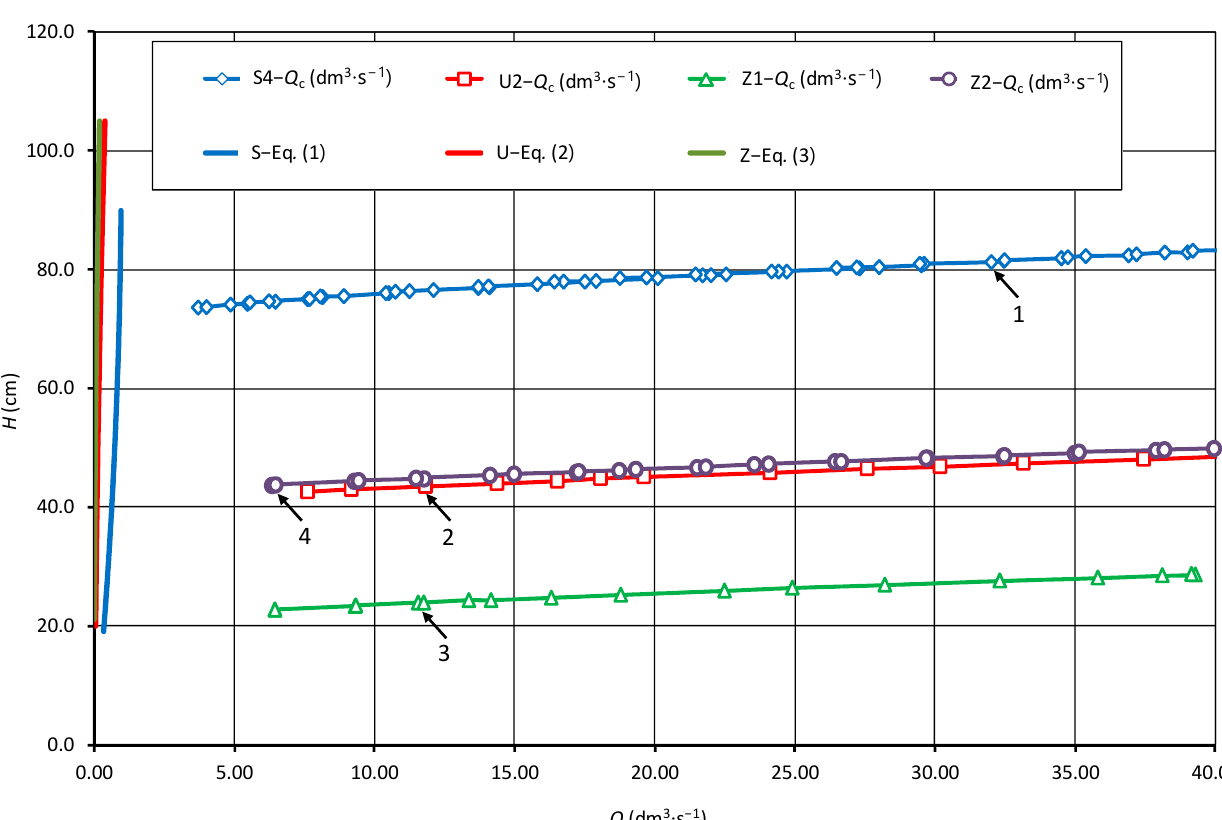
Figure 7. Discharge curves of regulators at different heights of the edge of the regulatory overflow: